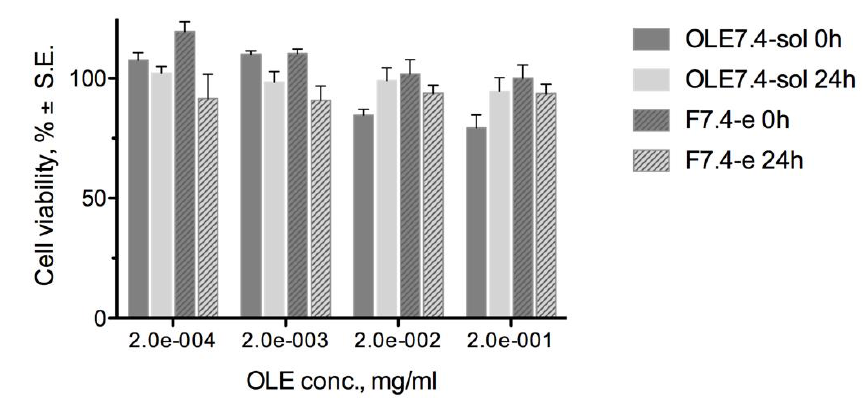
Figure 5. Cell viability of RCE cells after 60 min of contact with OLE formulations and subsequent recovery of 0 or 24 h in growth medium.